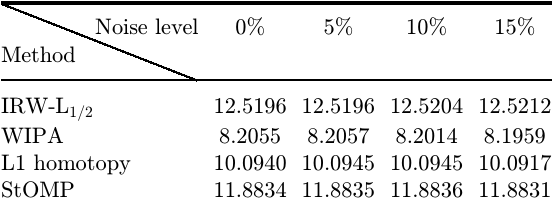
Table 3. CNR under di®erent noise levels in single- source